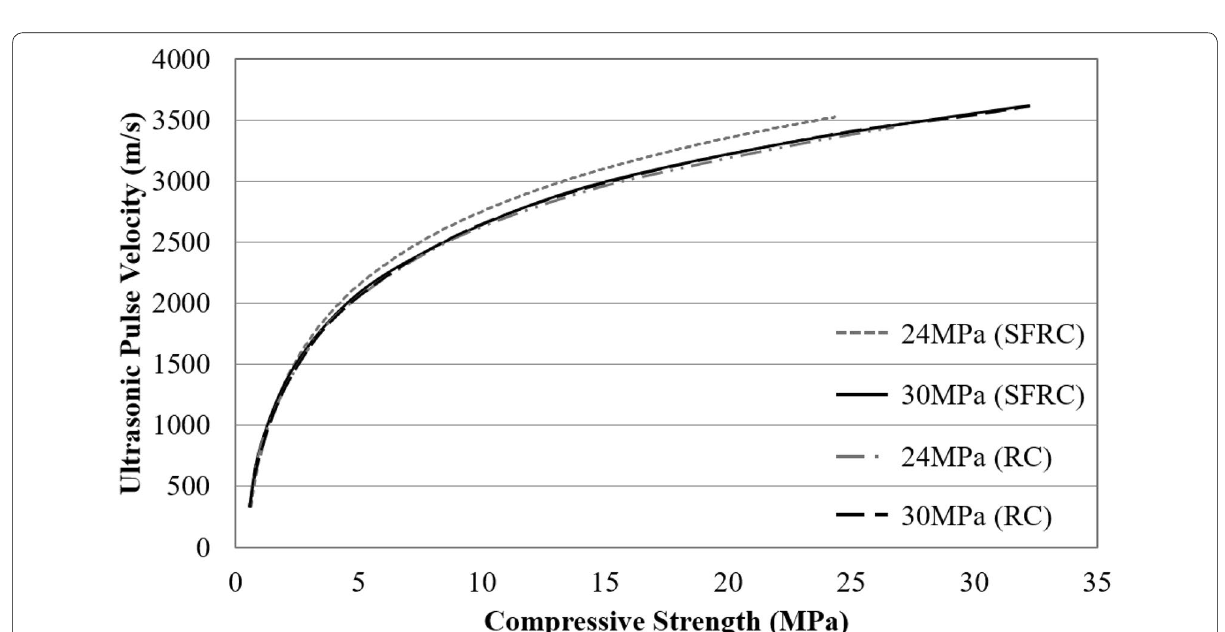
Fig. 7 Comparison of relation of ultrasonic pulse velocity and compressive